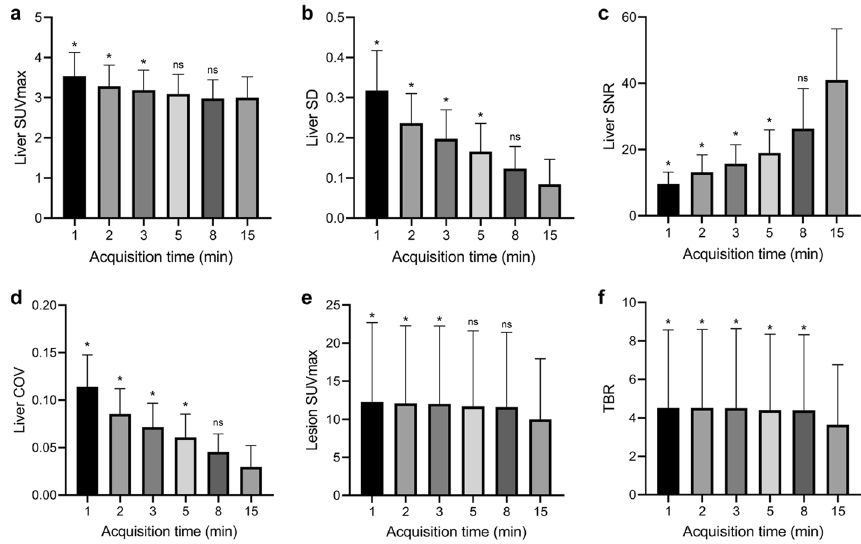
Fig. 2 Box plots for comparison of quantitative parameters in liver ( a – d ) and lesion ( e – f ) among groups. In general, the liver uptake and image noise decreased as the acquisition time increased, while the SNR of liver gradually increased. G15 served as control; there were no significant differences between G8 and G15 for any of these parameters ( a – d ). For lesions, SUV max ( e ) was significantly lower on G15 images than on G3, G2, and G1 images, but did not differ significantly between G15 and G8 ( p > 0.99) or between G15 and G5 ( p 0.35). The TBR ( f ) significantly differed between short-duration images and G15 images. = SUV standardized uptake value, SD standard deviation, SNR signal-to-noise ratio, COV coefficient of = = = = variation, TBR tumor-to-background ratio ( * indicate p < 0.05; ns, not =